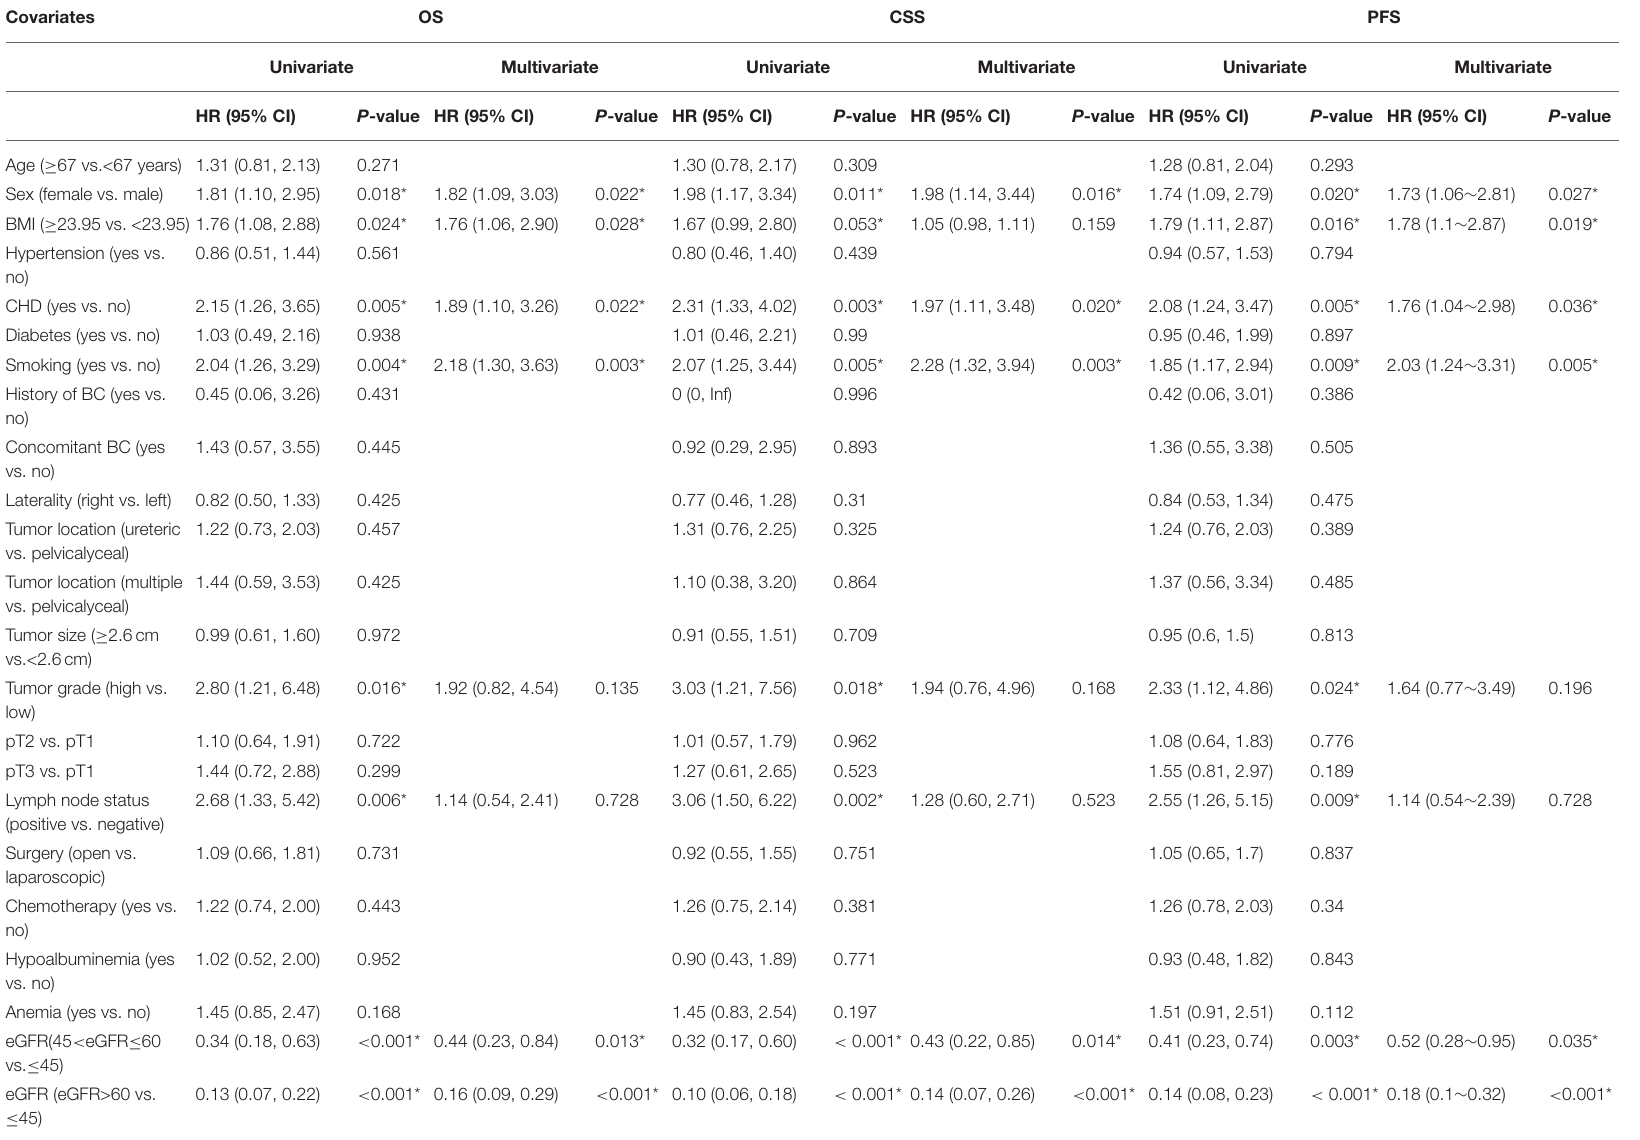
TABLE 2 | Univariate and multivariate Cox regression analyses of clinicopathological parameters for the prediction of survival outcomes in patients with UTUC treated with RNU. Covariates OS CSS PFS Univariate Multivariate Univariate Multivariate Univariate Multivariate HR (95% CI) P -value HR (95% CI) P -value HR (95% CI) P -value HR (95% CI) P -value HR (95% CI) P -value HR (95% CI) P -value